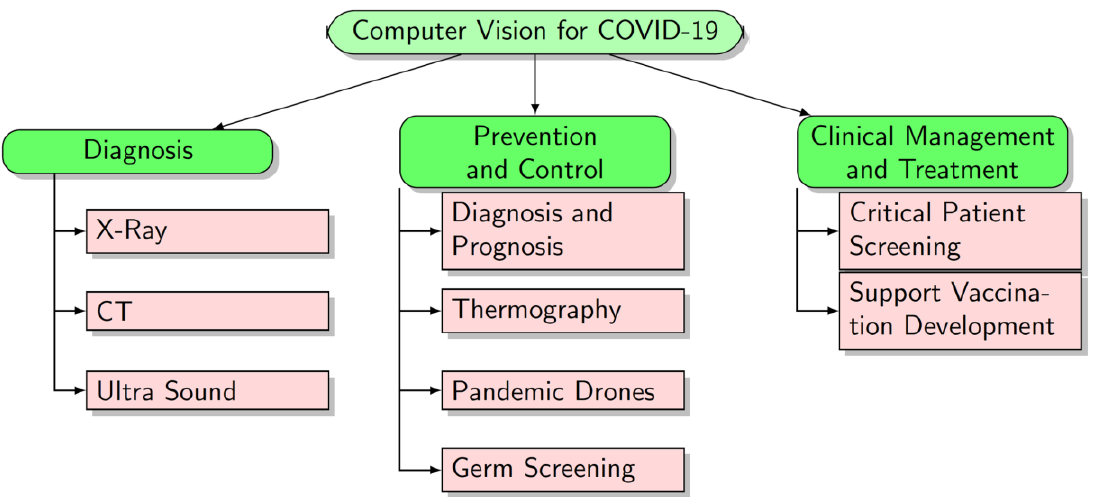
Figure 24. Classification of computer vision approaches for COVID-19. Our survey classifies COVID-19 related computer vision methods into three broad categories [103]. Abbreviations used: COVID-19, Coronavirus disease 2019; and CT, Computed Tomography.